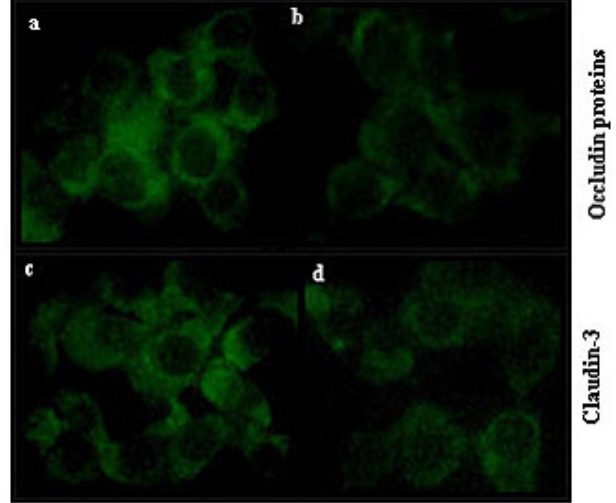
Figure 6. Effects of SBA on the distribution of tight junction proteins. The distributions of occludin treated with 0 mg/mL ( a ) or treated with 0.5 mg/mL ( b ) and claudin-3 treated with 0 mg/mL ( c ) or treated with 0.5 mg/mL ( d ), were determined by immunofluorescence. IPEC-J2 cells were grown on glass slides within 6-well plates until reaching complete confluence and were then treated with 0 or 0.5 mg/mL SBA for 48 h. The cells treated with 0 mg/mL SBA for 48 h were used as a control. Representative images are shown at a magnification of